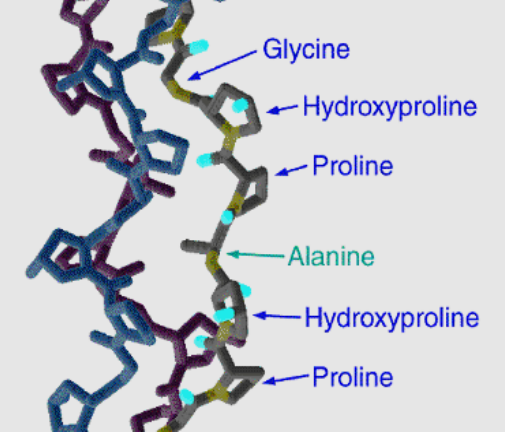
Figure 2. Three polypeptide α -chains form a triple-helix of gelatin. Gelatin is stabilized by the formation of covalent cross-links, both within the gelatin triple helix and between gelatin helices.